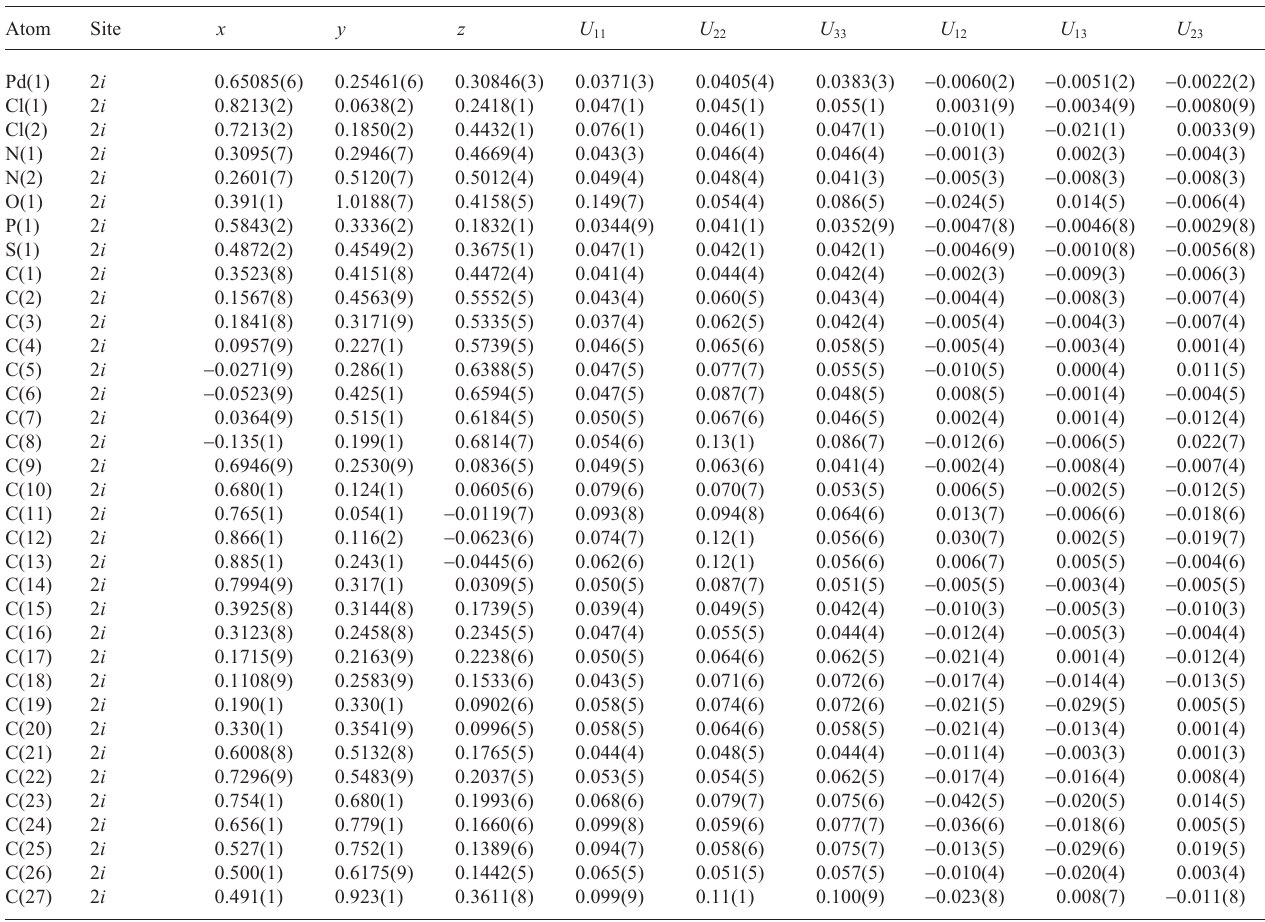
Table 3. Atomic coordinates and displacement parameters (in Å 2 )